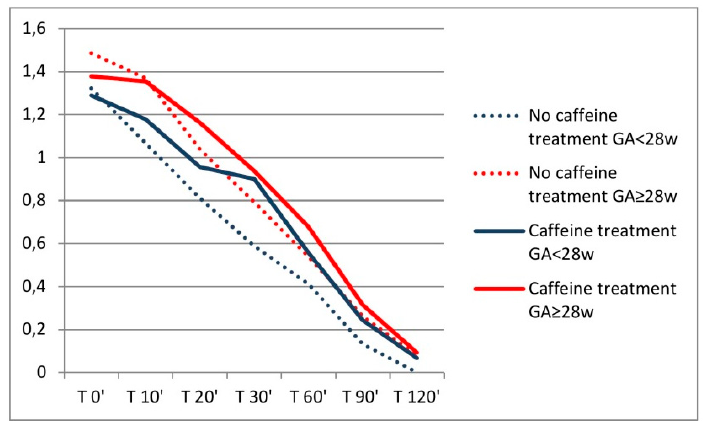
Figure 3. Distribution of ACSA values (means) reduction through different study time points with regards to caffeine treatment and depending on gestational age (GA) in weeks (w).